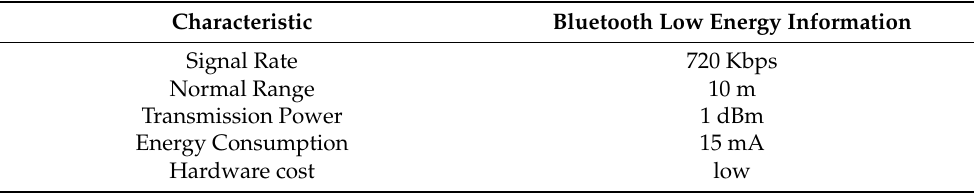
Table 1. The BLE